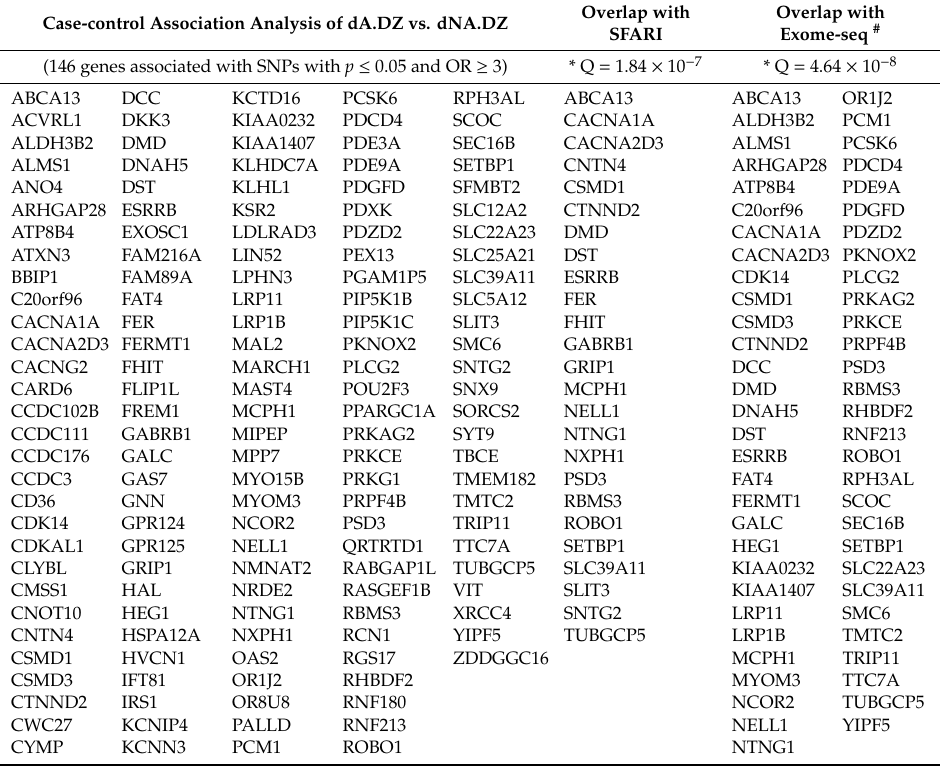
Overlap with Overlap with SFARI Exome-seq #